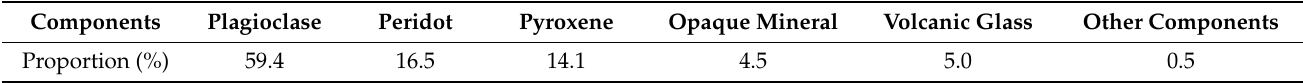
Table 1. The raw materials’ composition and proportion in volume of GUG-1B.